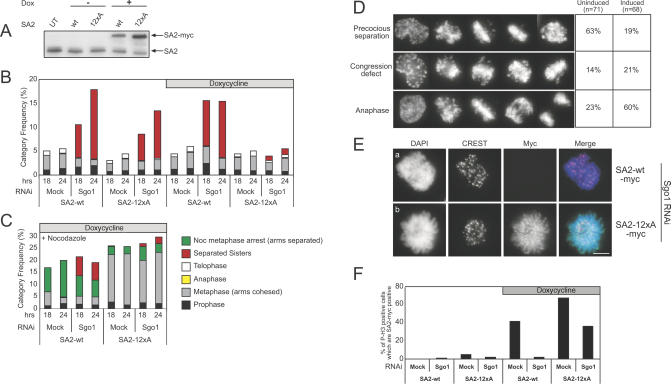
Expression of Nonphosphorylatable Scc3-SA2 Suppresses Sgo1-Depletion Phenotype(A) Total cell extracts prepared from HeLa cells that, upon doxycycline treatment, inducibly express either a wild-type (SA2-wt) or nonphosphorylatable (SA2–12xA) myc-tagged version of Scc3-SA2 were resolved by SDS-PAGE and probed with anti-SA2 antibody. The lower band represents endogenous Scc3-SA2, the upper band, myc-tagged Scc3-SA2. The first lane contains total cell extract prepared from untagged HeLa cells.(B) Expression of nonphosphorylatable Scc3-SA2 suppresses sister separation caused by Sgo1 depletion. Cycling HeLa cells carrying inducible myc-tagged versions of Scc3-SA2 were treated with (or without) doxycycline at 2 μg/ml for 72 h prior to and during transfection to induce expression, as indicated. Cells were harvested 18 h and 24 h post transfection, chromosomes were spread on glass slides and Giemsa-stained. As in Figure 7, the percentage of mitotic cells were calculated out of 200 cells, and mitotic chromosome spreads were then further classified into one of five categories (n = 200 mitotic spreads for each time point). The frequency of each category of mitotic cell (see examples in Figures 3B, 7B, and 7D) is given as a percentage of total cell numbers, such that the sum of each column represents the mitotic index.(C) Nonphosphorylatable Scc3-SA2-mediated suppression is still observed when combined with nocodazole arrest. The indicated treatments were repeated as outlined in (B) in the presence of nocodazole which was added to cultures 4 h posttransfection, i.e., 14 and 20 h prior to harvesting of cells. Samples were processed as in (B), with the addition of a sixth mitotic category.(D) Live cell analysis of Sgo1 depletion of nonphosphorylatable Scc3-SA2 (SA2–12xA) expressing cells. To follow chromosome behaviour, cells stably expressing EGFP-H2B and inducibly expressing SA2–12xA were used. Expression of SA2–12xA was induced 72 h prior to transfection as in (B). Cells were transfected with Sgo1 siRNA as in Figure 1A and examined by time-lapse fluorescence microscopy. Significant number of cells exit mitosis by expressing nonphosphorylatable Scc3-SA2.(E) Nonphosphorylatable SA2 (SA2–12xA) is found at centromeres even in the absence of Sgo1. HeLa cells containing either the myc-tagged wild-type (a) or SA2–12xA (b) inducible transgene were either uninduced or induced as in (B) 72 h before transfection. Transfection of Sgo1 siRNA was performed prior to the second thymidine block as in Figure 1A. At 8.5 h after the release from early S phase, mitotic cells were spun down on glass slides and analysed for cohesin localisation by immunofluorescence microscopy using antibodies to the myc epitope (shown in green). Cells were costained with CREST antiserum to label kinetochores (shown in red) DNA was counterstained with DAPI (shown in blue).(F) Quantification of SA2-myc staining. Samples similar to those described in (E) were stained with myc and P-H3 antibodies (the latter to identify cells from prophase to metaphase). Approximately 200 P-H3-positive cells were assessed for SA2-myc staining, and the percentage of cells that were both P-H3- and SA2-myc-positive was plotted. We believe that the apparent drop in the number of SA2–12xA-myc positive cells observed with depletion of Sgo1 relative to mock transfection is a statistical artefact caused by the mitotic arrest and accumulation of those cells that did not express SA2–12xA-myc (∼30%) but that were depleted of Sgo1.